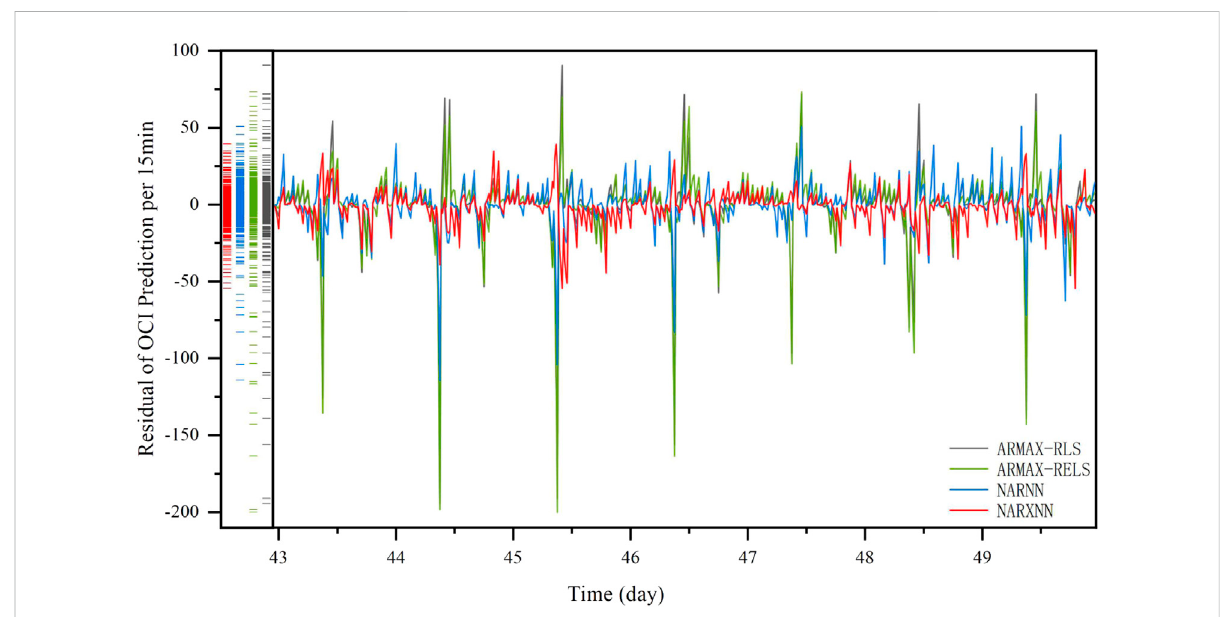
FIGURE 6 Prediction residual of OCI for the last 7 days over four steps ahead.